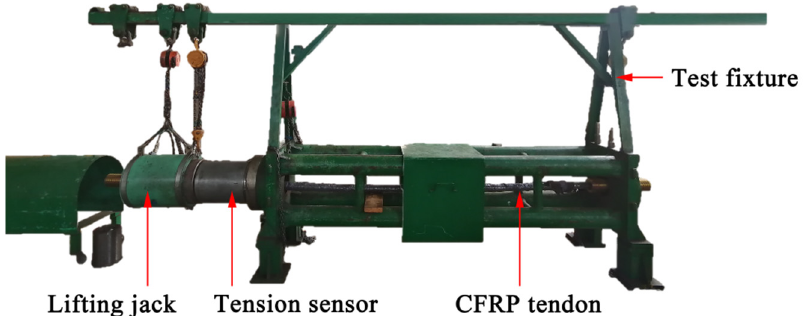
Figure 6. CFRP tendons and the test device.